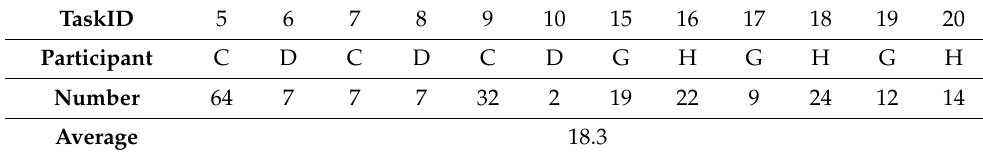
Table 4. Number of conceptions in the collaboration group.